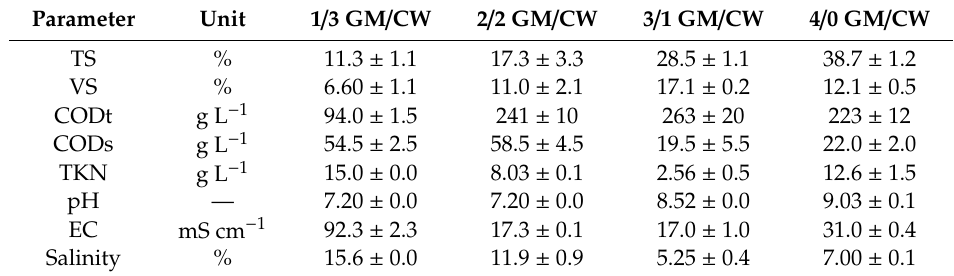
Table 4. Physicochemical characteristics of digester nutrient at start-up. Codigestion setups of grape marc (GM) and cheese whey (CW), on wet weight basis, were of ratios 1 / 3 GM / CW; 2 / 2 GM / CW; 3 / 1 GM / CW; and 4 / 0 GM / CW. Values recorded as mean ± standard